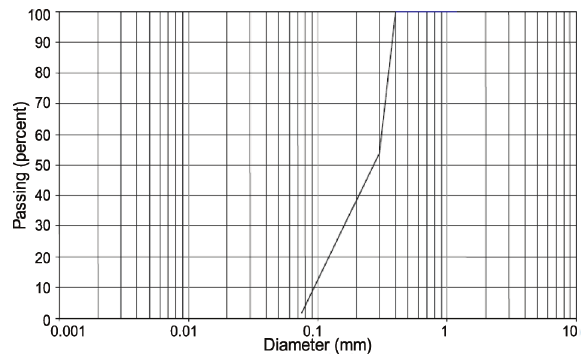
Fig. 1. Grain size distribution Table 6. Characteristics of SBS used in this study Test method